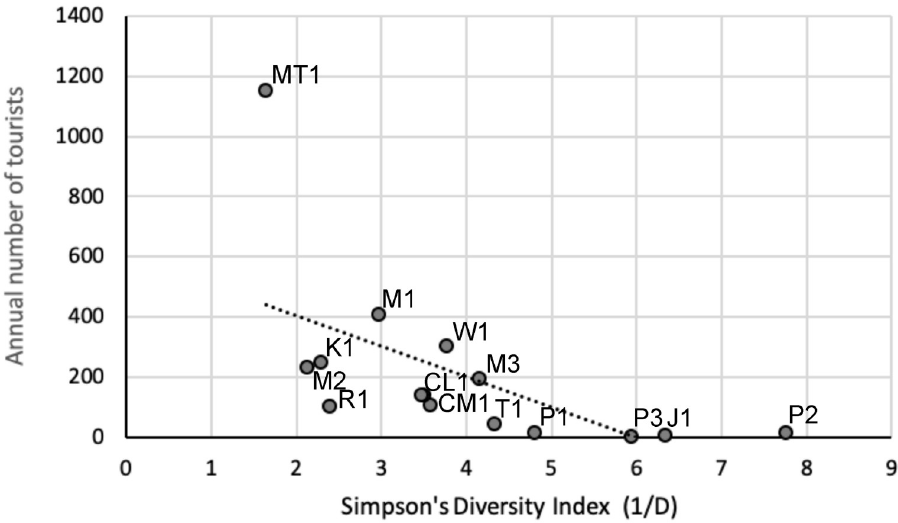
Fig 2. Impact of the annual number of tourist triggers per camera station on the Simpson’s Diversity Index (1/D).